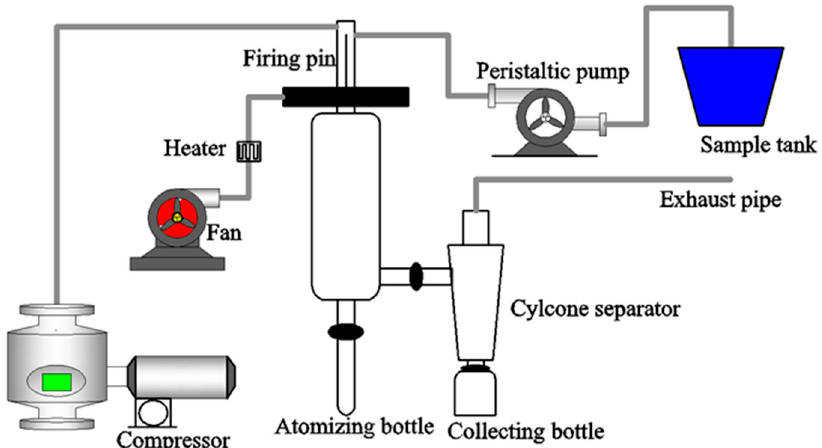
Figure 1. Schematic diagram of experimental spray-drying system.